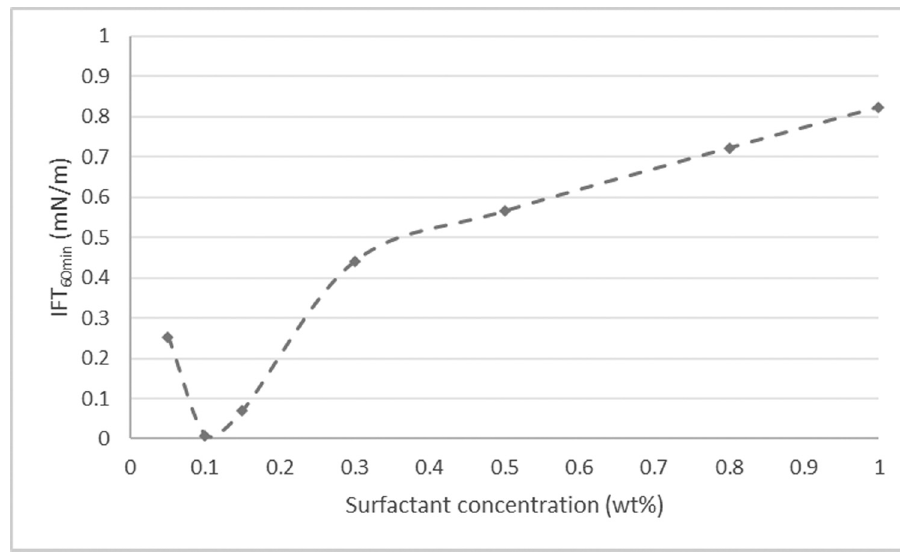
Figure 8: IFT results for S6 surfactant ‒ brine ‒ oil at reservoir temperature and a concentration of 0.05 – 1.0